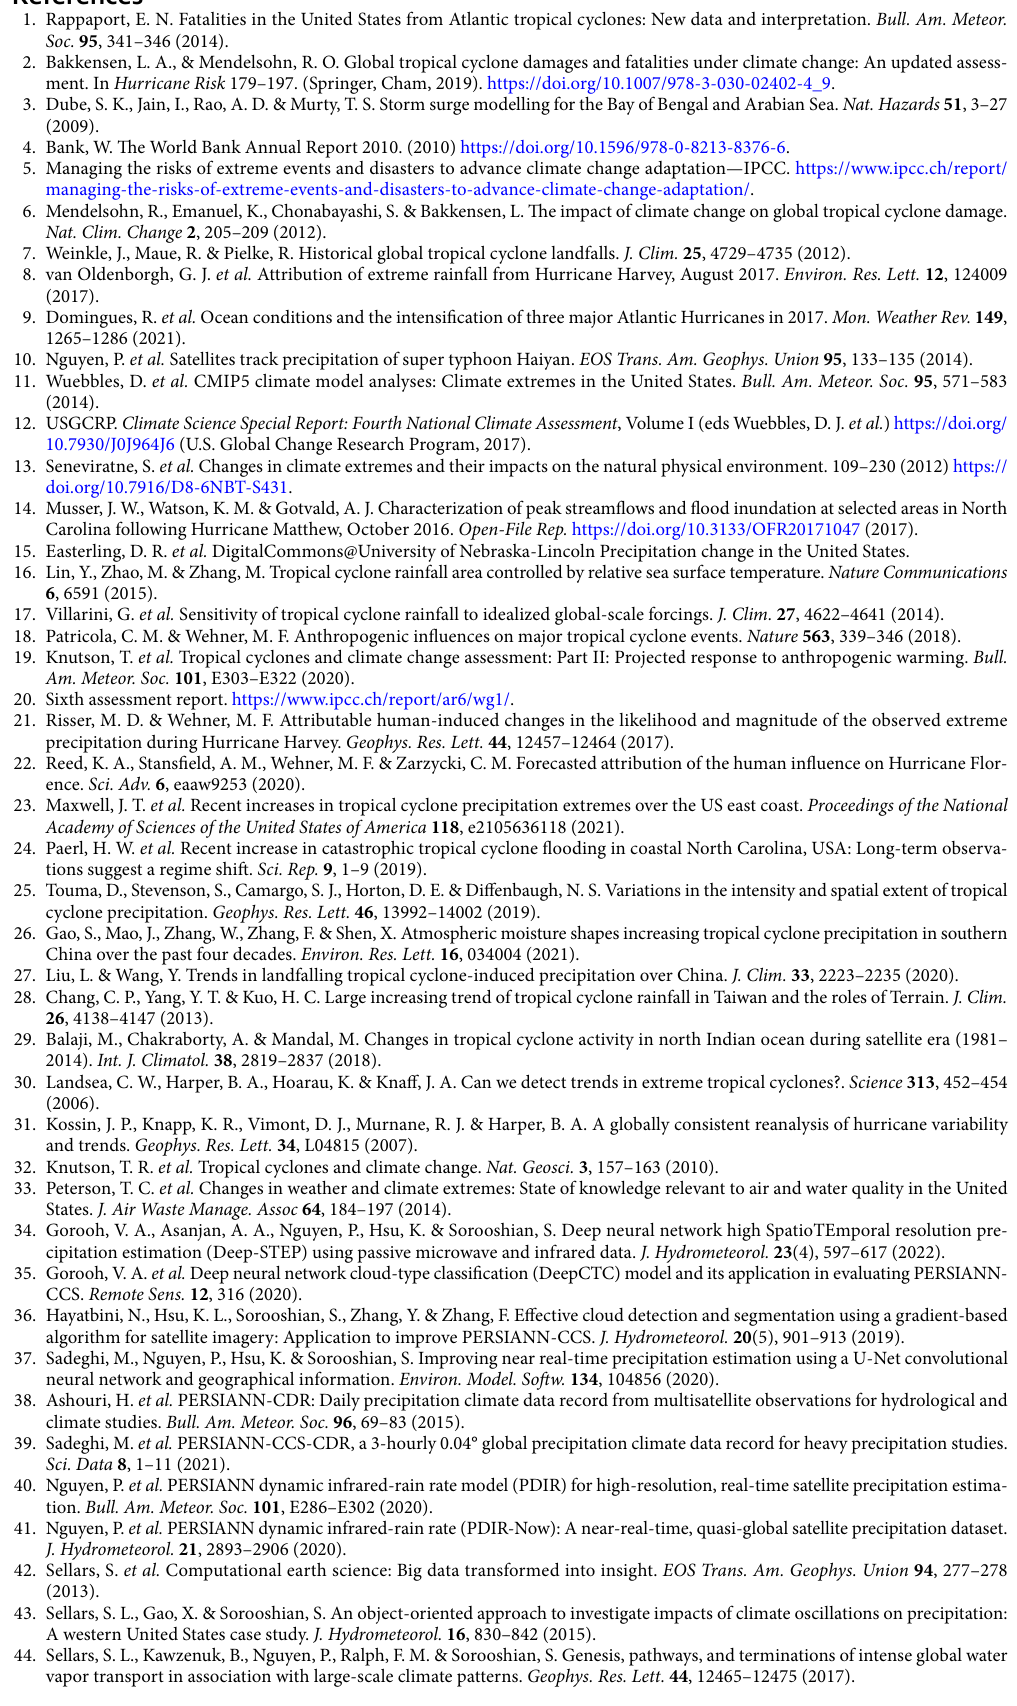
algorithm for satellite imagery: Application to improve PERSIANN-CCS. J. Hydrometeorol. 20 (5), 901–913 (2019). 37. Sadeghi, M., Nguyen, P., Hsu, K. & Sorooshian, S. Improving near real-time precipitation estimation using a U-Net convolutional neural network and geographical information. Environ. Model. Softw. 134 , 104856 (2020). 38. Ashouri, H. et al. PERSIANN-CDR: Daily precipitation climate data record from multisatellite observations for hydrological